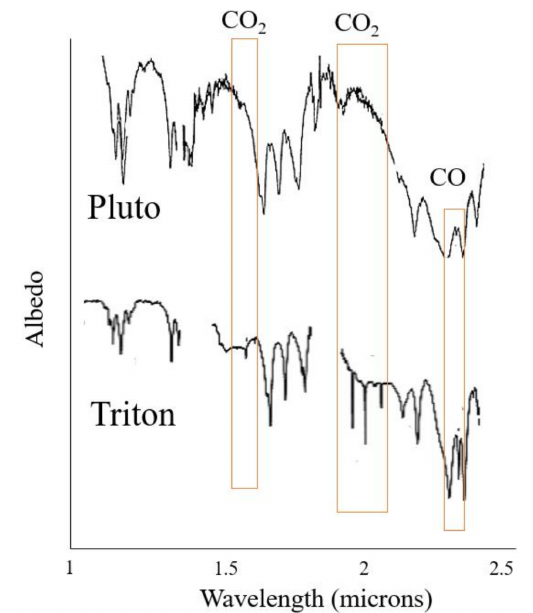
Figure 6. Telescopic spectra of Triton and Pluto with labeled CO 2 (1.65, 1.96 µ m) and CO (2.35 µ m) spectral bands. It should be noted that most of the remaining CO and CO 2 bands are spectrally interfered by more dominant CH 4 spectral bands [87]. (Pluto’s spectrum obtained from the UKIRT (adapted from [94]); Triton’s spectrum is averaged IRTF/SpeX (adapted from